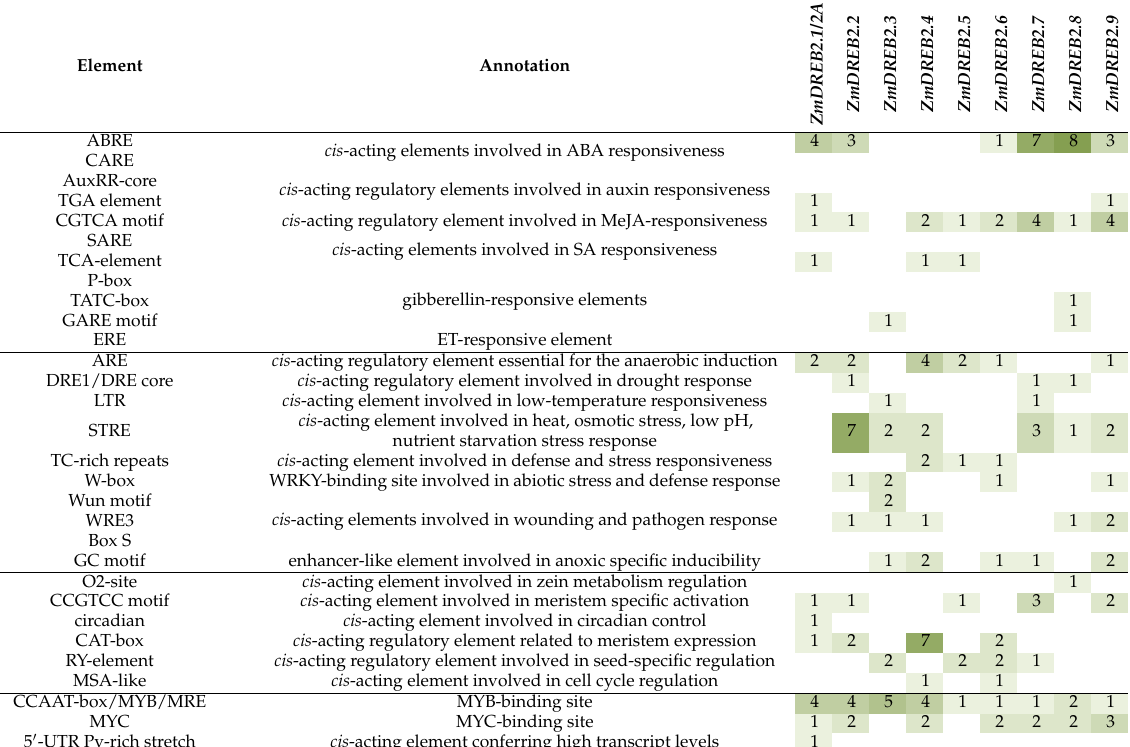
Table 2. Hormone- and stress-responsive cis -elements in the ZmDREB2.1/2A–2.9 regulatory regions (~1000 bp). The color scheme (pale to dark) corresponds to the number of cis -elements (low to